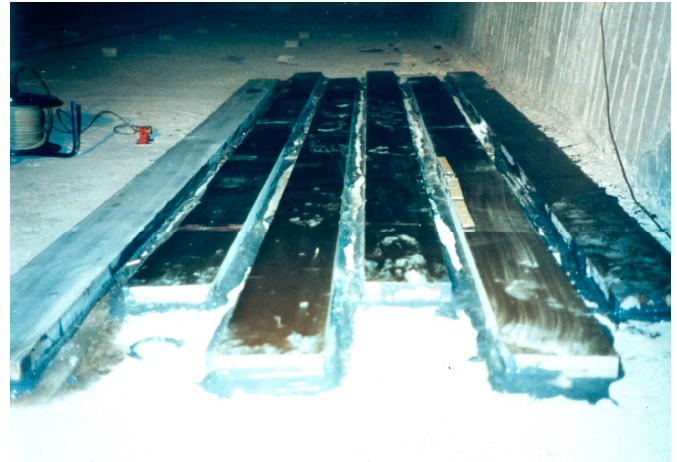
Figure 5. Glass fiber reinforced polymer (GFRP) Plates at the bottom slab of Kattenbusch Bridge (Source: Prof. Ferdinand S. Rostásy).